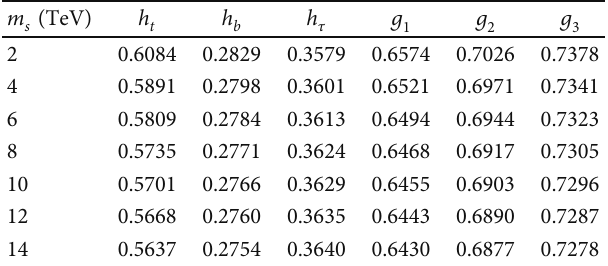
Table 5: Values of Yukawa and gauge couplings t GeV Þ = 34 : 53 for tan β = 40 , for di ff erent choices of m